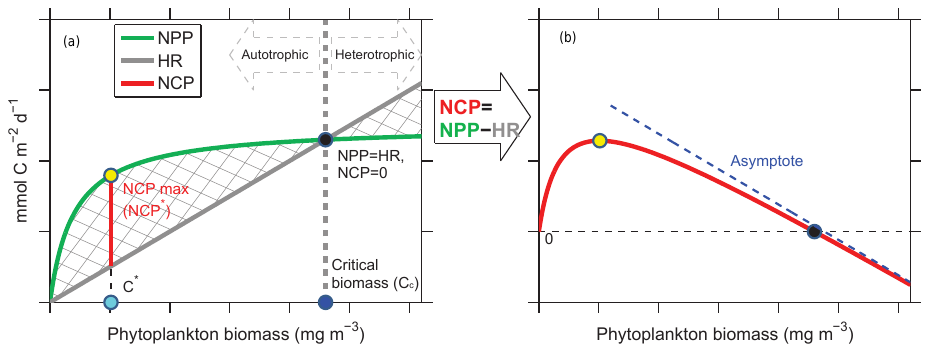
Figure 2. Relationship between net primary production (NPP), heterotrophic respiration (HR), net community production (NCP), and phy- toplankton biomass concentration ( C ) for a given mixed layer depth (MLD). The hatched area in panel (a) represents NCP. The yellow dot represents the maximal NCP (NCP ∗ ) obtainable for a given MLD, with the corresponding phytoplankton biomass concentration ( C ∗ ) denoted with a cyan dot. NCP on the right of the yellow dot decreases with C due to self-shading. The black dot represents depth-integrated NCP = 0 (i.e., NPP = HR), with the corresponding phytoplankton biomass concentration defined as critical biomass ( C c ) and denoted with a blue dot. Ecosystems on the left and right of this threshold are net autotrophic and heterotrophic, respectively. The asymptote (dashed blue line) in panel (b) represents a system dominated by heterotrophic respiration (i.e., NCP ≈ HR (cid:29)